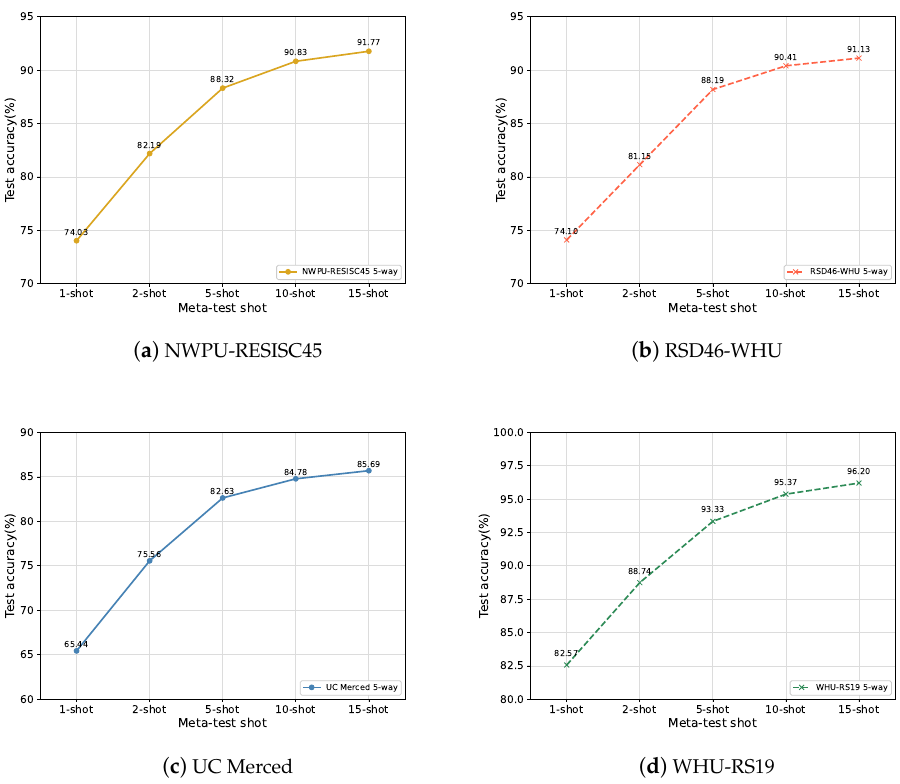
Figure 8. Comparison of different shots for the meta-test on four datasets: ( a ) NWPU-RESISC45 ( b ) RSD46-WHU ( c ) UC Merced ( d )